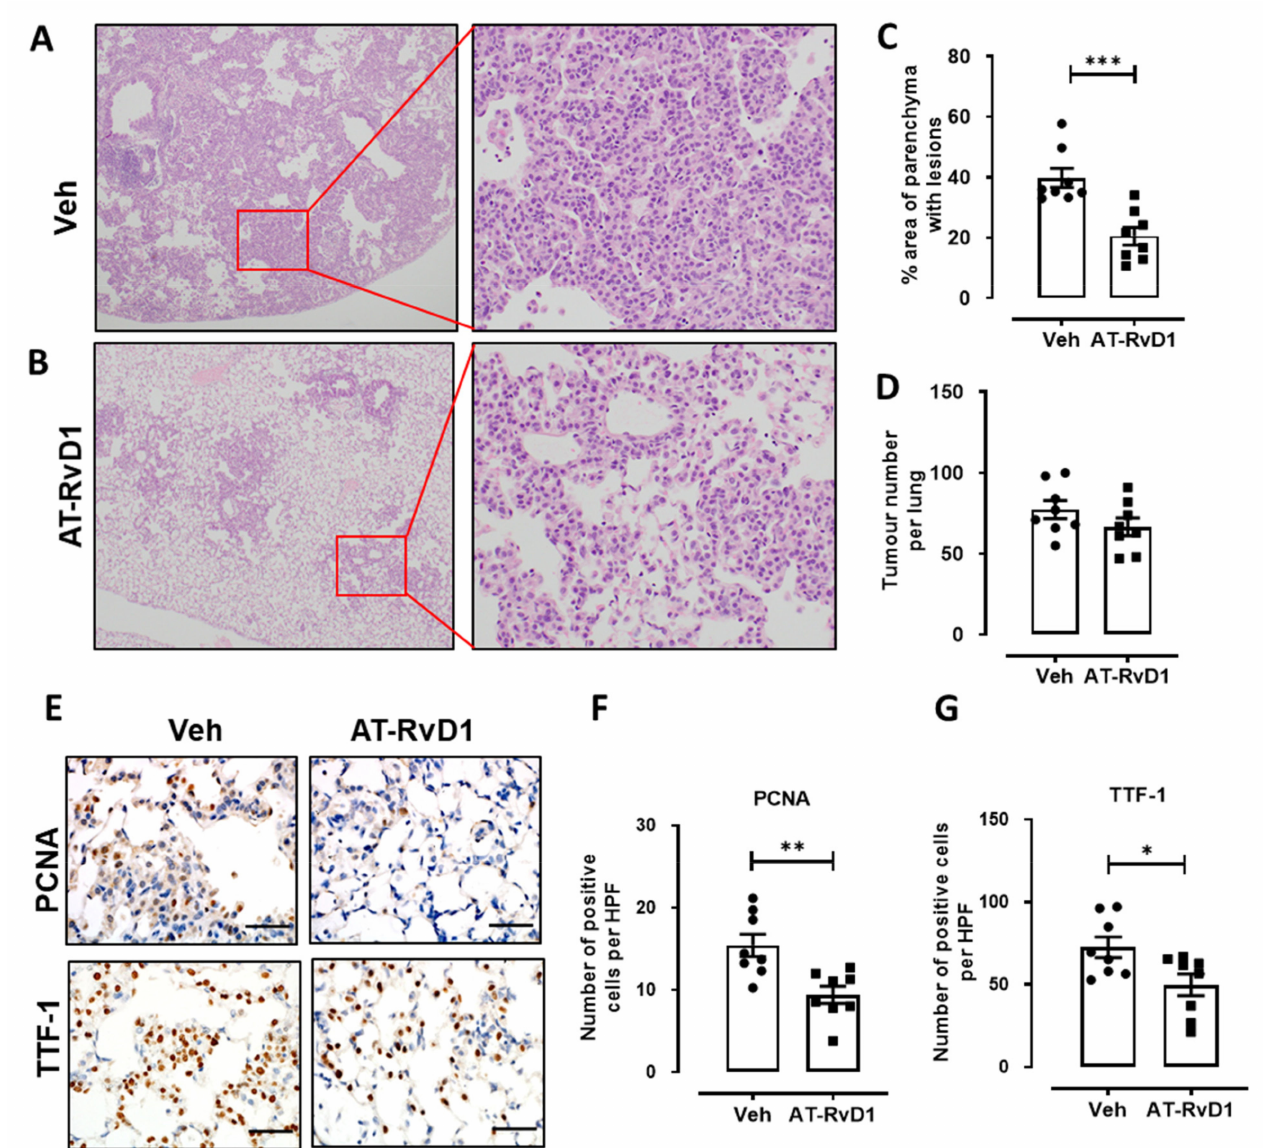
Figure 4. AT-RvD1 reduced tumour burden in Kras G12D mice. ( A ) Representative images of parenchymal lesions that develop in response to adeno-CRE delivery following 6 weeks of induction in vehicle treated mice (original magnification, × 40 & × 100). ( B ) Representative images of parenchymal lesions that develop in response to adeno-CRE delivery (original magnification, × 40 & × 200) following 6 weeks of induction in AT-RvD1 treated mice (400ng, 2 × weekly). ( C ) Quantification of lung parenchyma area occupied by tumour lesions and ( D ) quantification of tumour incidence per whole lung across the treatment groups. ( E ) Representative images of PCNA and TTF-1 stained lung sections (original magnification, × 200) and ( F ) quantification of PCNA positive cells per high powered field in lungs of the indicated treatment groups. ( G ) Quantification of TTF-1 positive cells per high powered field in lungs of the indicated treatment groups. n = 8 per group, *** p < 0.0005, ** p < 0.01, * p < 0.05 unpaired t